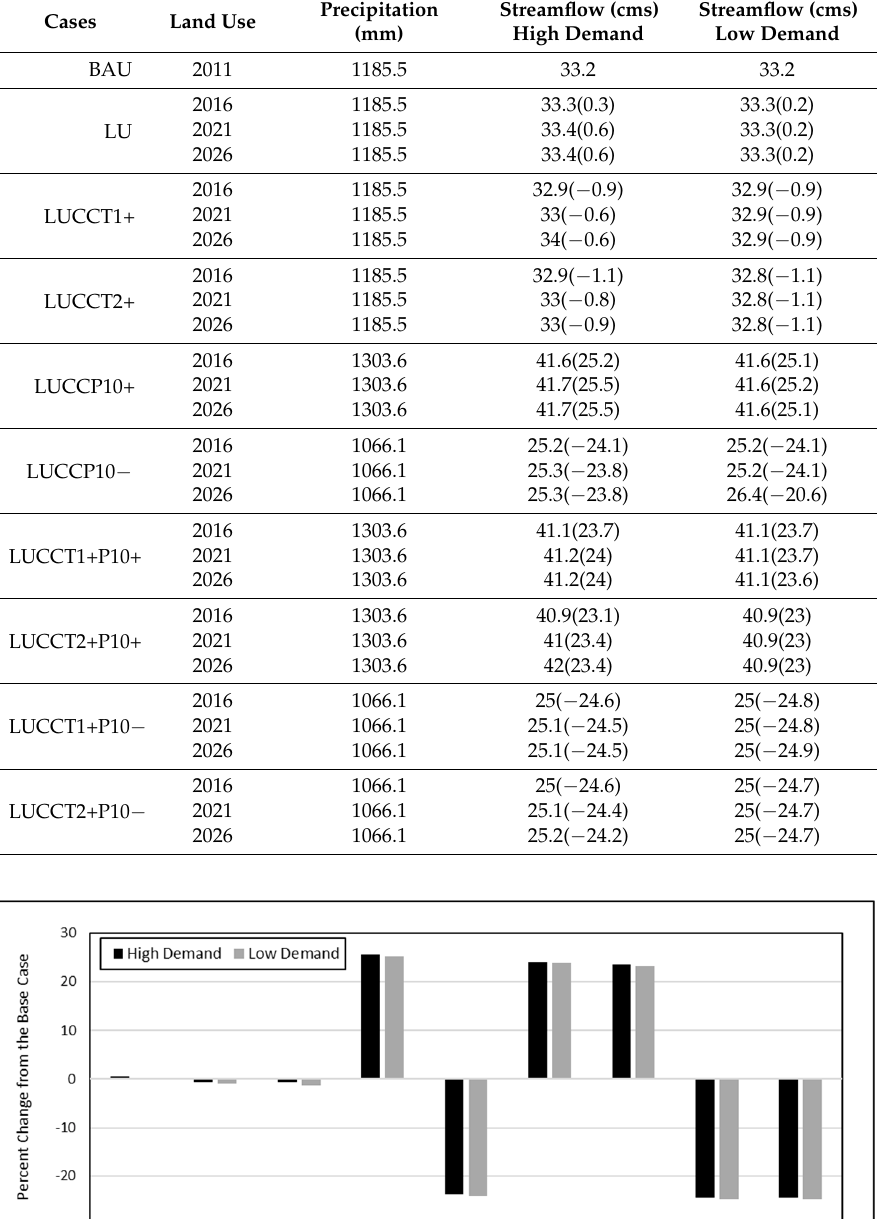
Table 7. Simulated average streamflow with High and Low Demand scenarios for ten cases. Values in the brackets are percentage change relative to the base case. Streamflow units are in cubic meters per second (cms).